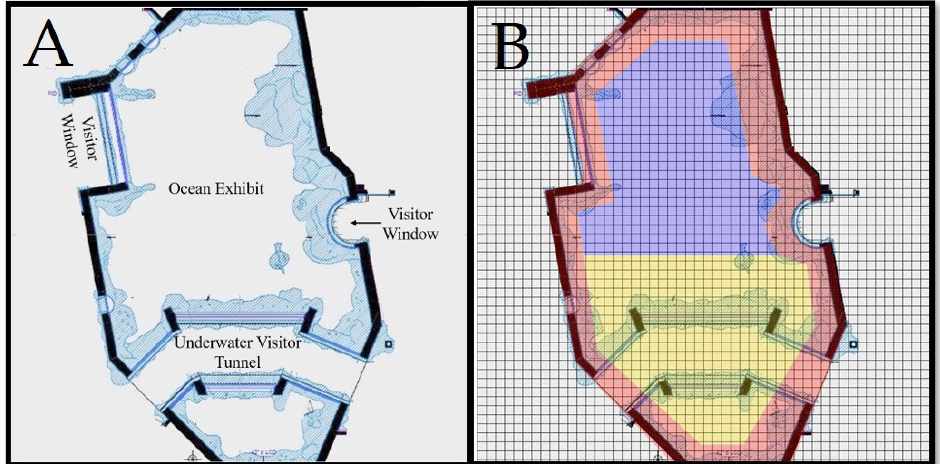
Figure 1. ( A ) The 2 ‐ D map of the Ocean Exhibit used to collect the Exhibit Use data. The thick black lines represent the perimeter of the exhibit, whereas the blue shades represent vertical rock for ‐ mations within the tank. The ‘underwater visitor tunnel’ was a submerged glass tunnel for visitors to walk through, over which the exhibit animals could swim. ( B ) Map with zones indicated, and the 50 × 50centimeter grid used to ensure the zones were of equal size. Zone ‘A’ is colored in yellow, Zone ‘B’ is blue, and Zone ‘C’ is